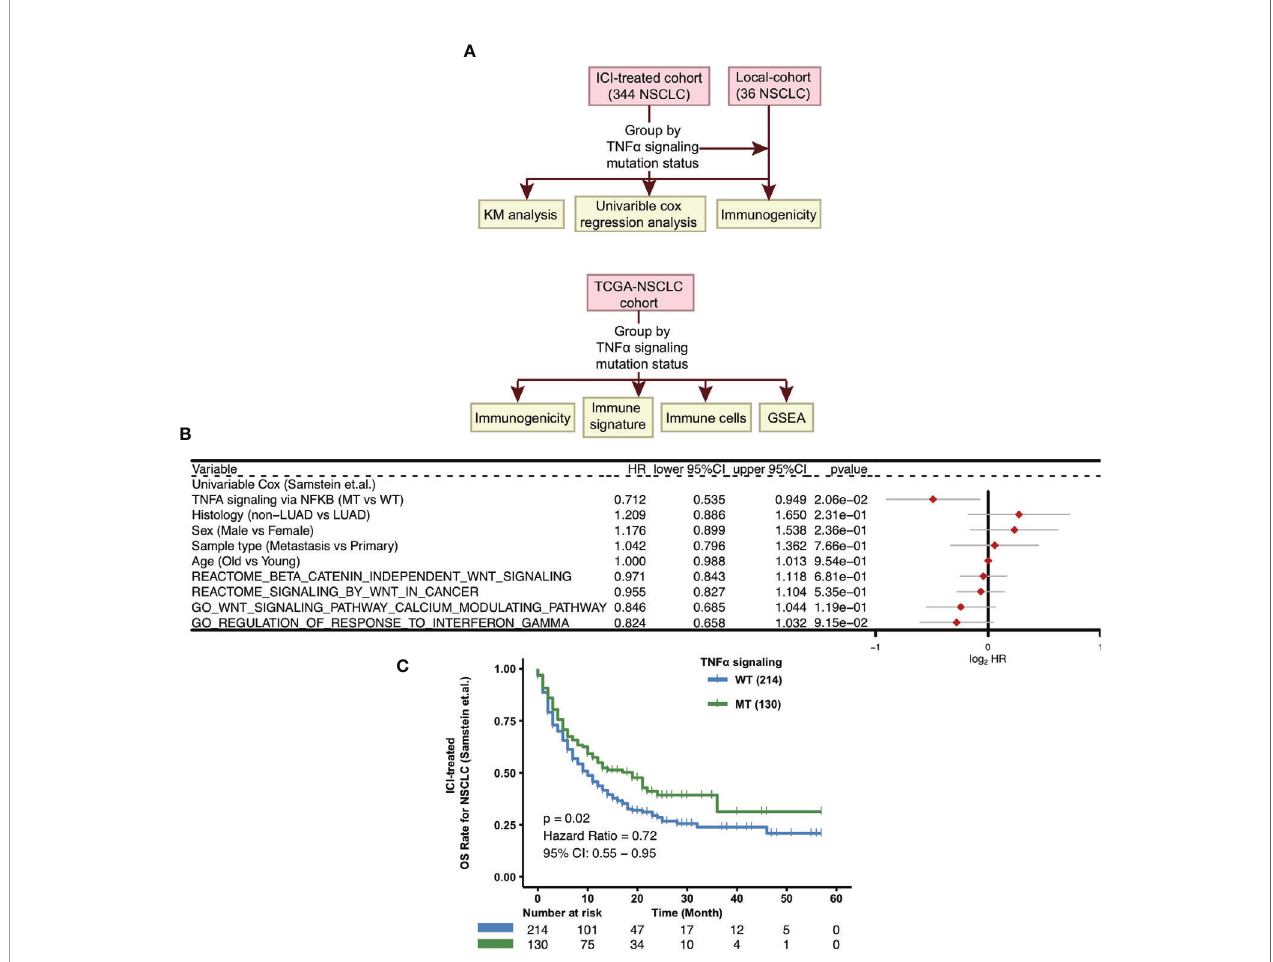
FIGURE 1 | Predictive values of clinical characteristics and the TNF a signaling mutation status on ICI outcomes. (A) Flow chart of the establishment of the clinical cohorts and subsequent analyses. (B) Forest plot of the results of the univariate Cox regression analyses. (C) KM survival curves for OS in NSCLC patients from the ICI-treated cohort. NSCLC, non small-cell lung cancer; TCGA, The Cancer Genome Atlas; ICI, immune checkpoint inhibitors; OS, overall survival; KM, Kaplan